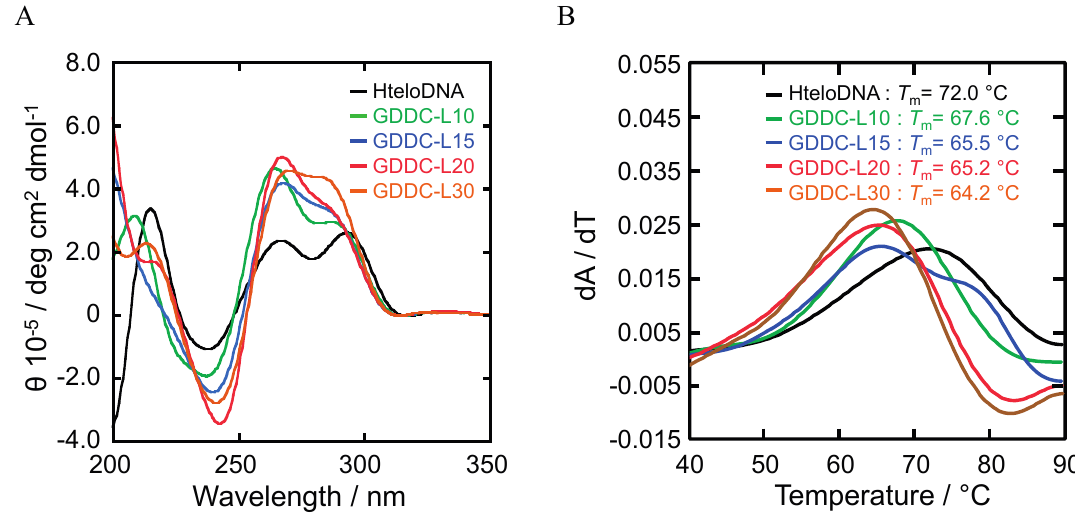
Figure 3. ( A ) CD spectra of HteloDNA and each GDDC at 25 °C in a buffer comprising 50 mM MES-LiOH (pH 7.0), 100 mM KCl, and 10 mM MgCl 2 . Before measurement, the plots derived from UV melting curves of G-quadruplexes formed by HteloDNA and